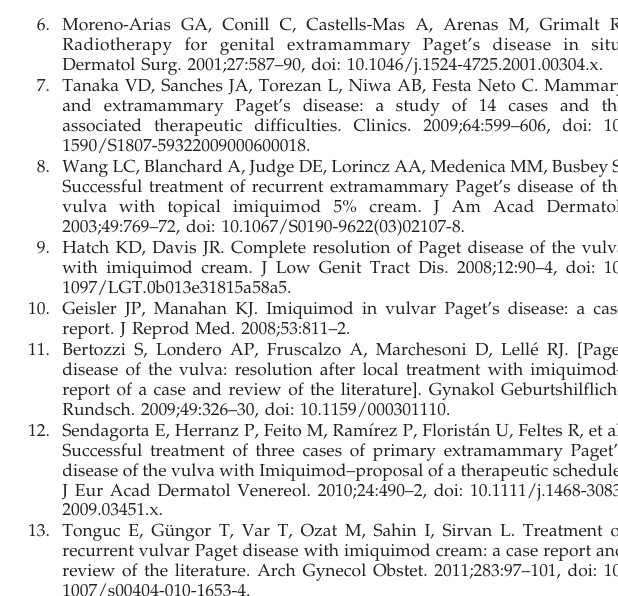
Figure 2 - Histological presentation of the vulvar skin showing pleomorphic large cells, isolated or in groups, among normal keratinocytes (left). These cells stained for cytokeratin 7 (middle) and were negative for Melan-A (right), allowing the diagnosis of extramammary